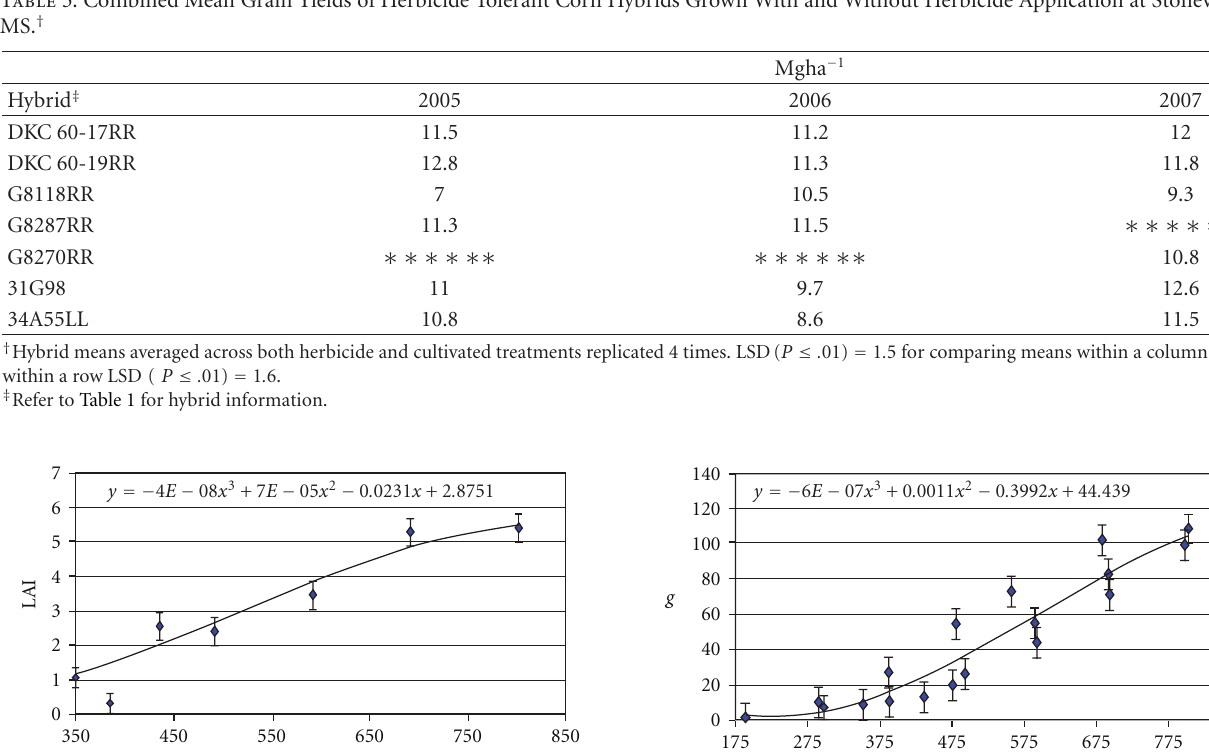
Table 5: Combined Mean Grain Yields of Herbicide Tolerant Corn Hybrids Grown With and Without Herbicide Application at Stoneville,